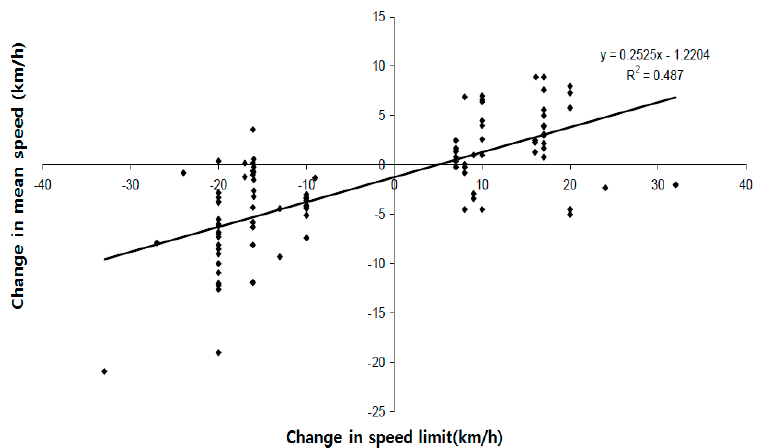
Figure 19. Relationship between changing the speed limit and the subsequent change in mean driv- ing